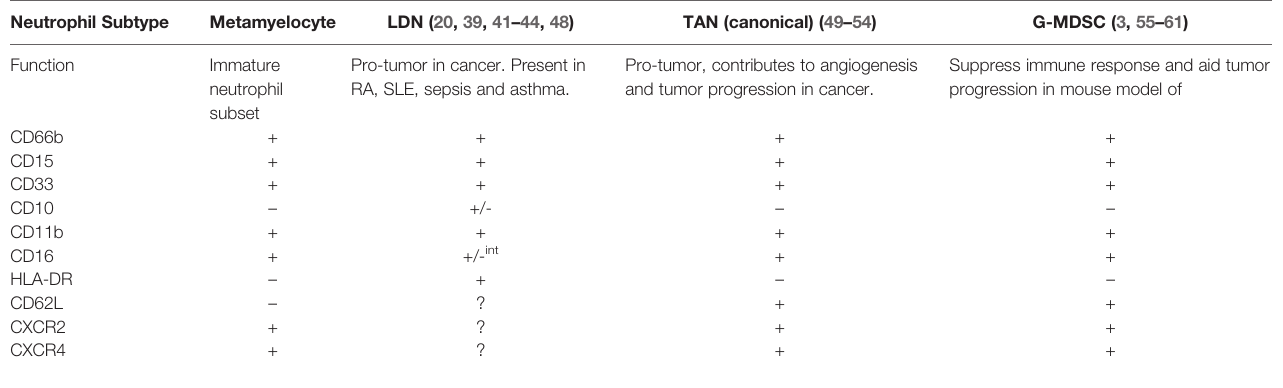
TABLE 1 | Surface marker and functional pro fi le of G-MDSC, TAN and LDN neutrophils. Neutrophil